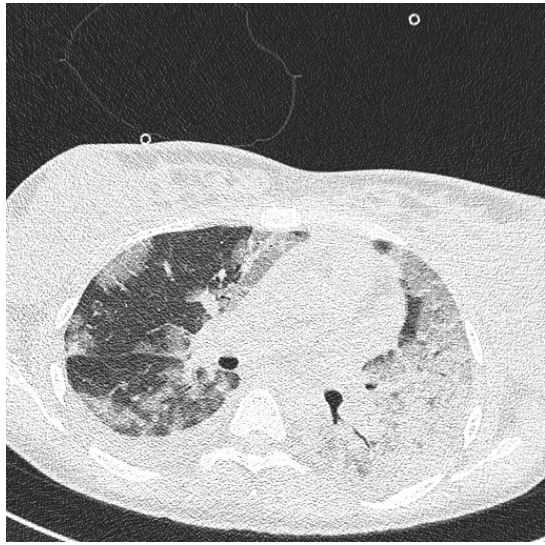
Figure 4. Chest Computed Tomography (HRCT).